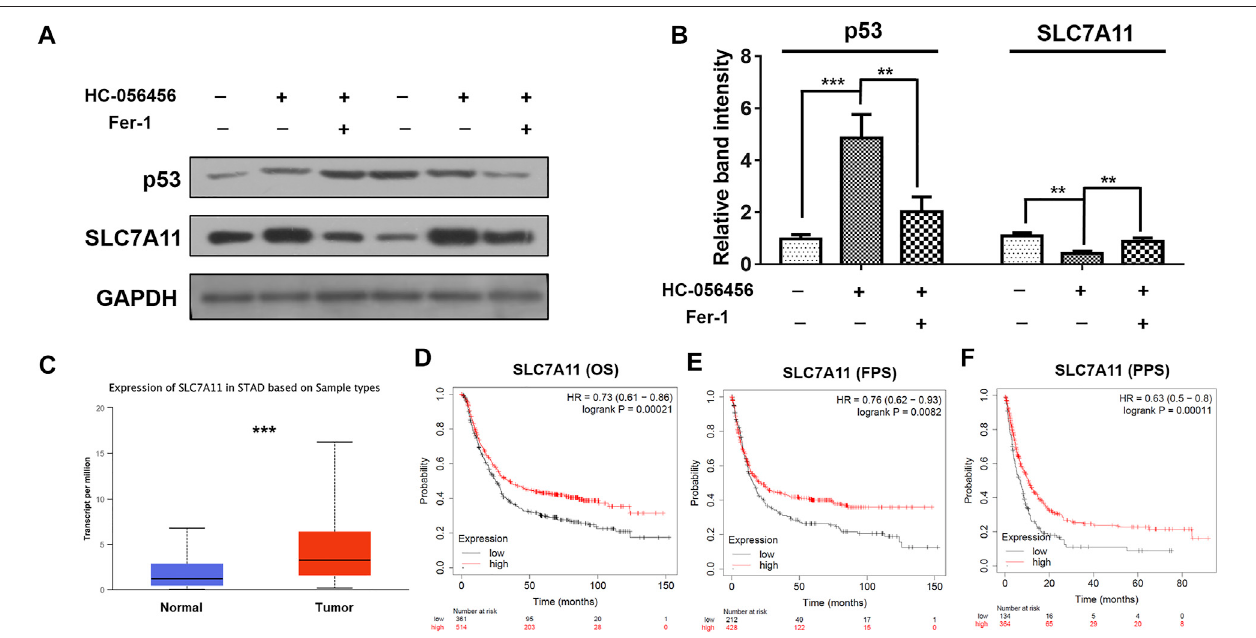
FIGURE 10 | HC-056456 excised the anti-gastric cancer effect in vivo by upregulating p53 and downregulating SLC7A11 (A) The levels of p53 and SLC7A11 of tumors in mice were detected by Western Blot, and (B) The pannels were analyzed by ImageJ (C) Correlation of SLC7A11 expression between gastric cancer and normal tissues. Relationship between SLC7A11 expression and (D) the overall survival (E) fi rst progression survival, and (F) post progression survival of gastric cancer patients. * p < 0.05, ** p < 0.01, *** p < 0.001 versus control group.